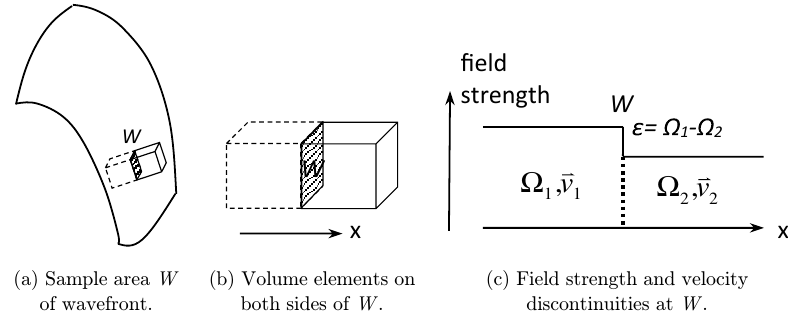
Fig. 2. A sample area of wavefront and volume elements around it.